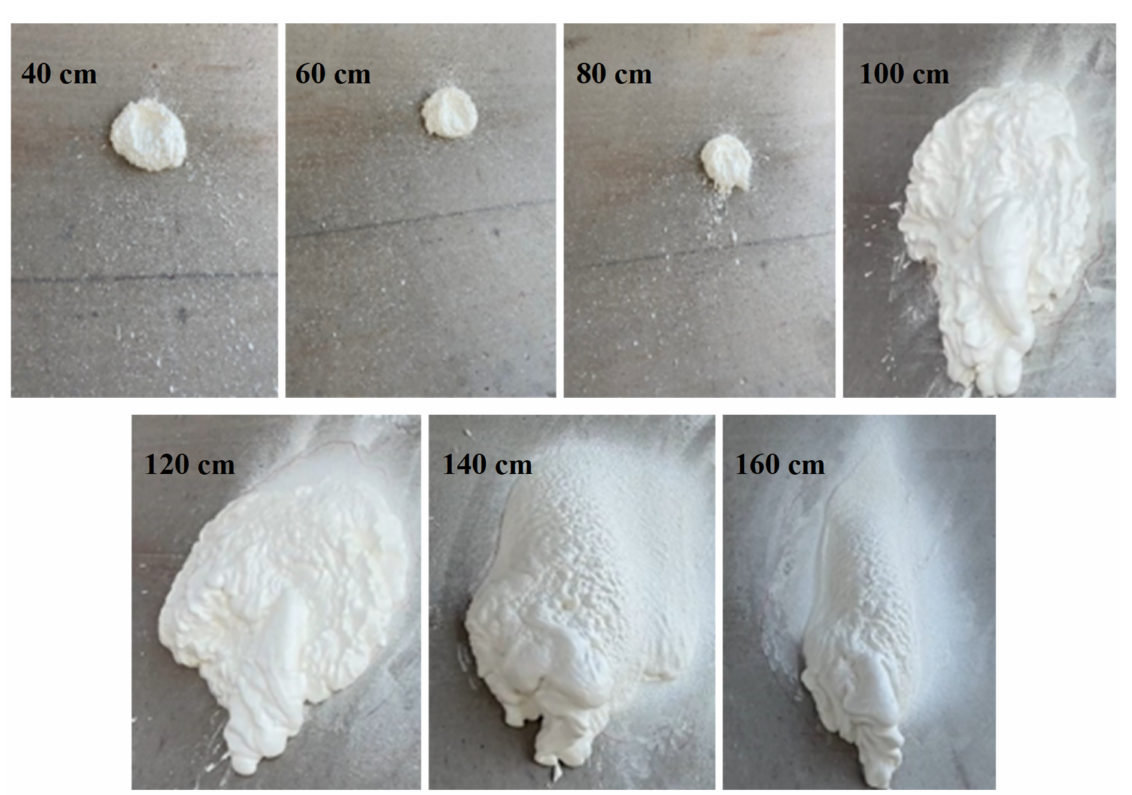
Figure 10. Spraying performance at different L spray